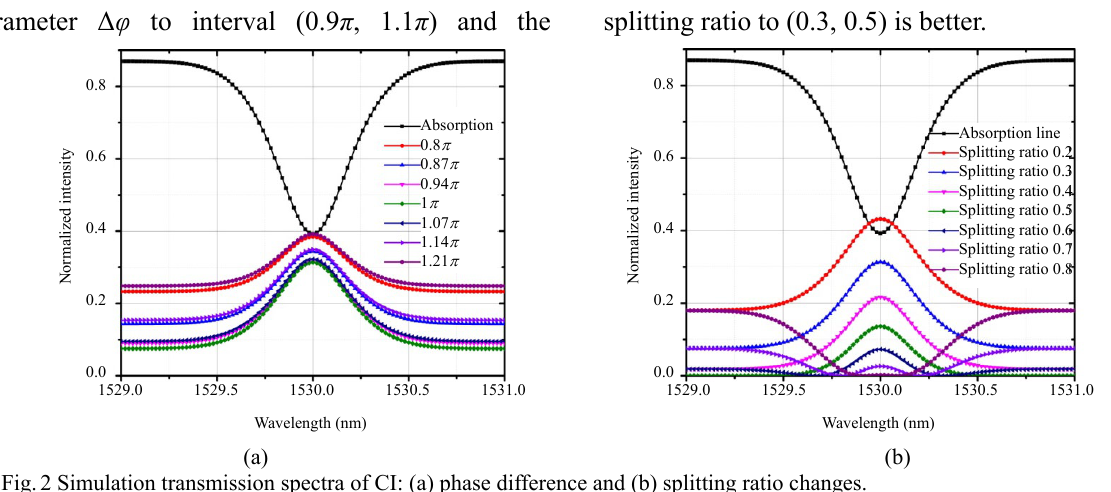
Fig. 2 Simulation transmission spectra of CI: (a) phase difference and (b) splitting ratio changes.